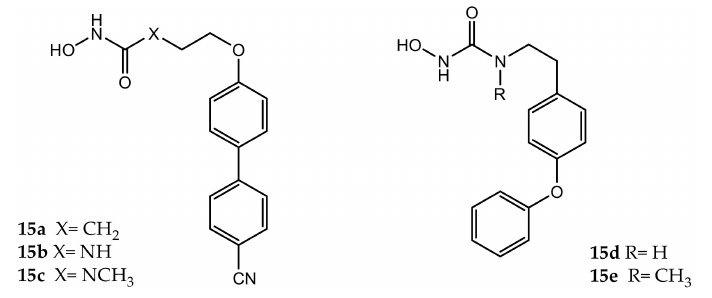
Figure 15. Compounds 15a–e [55].